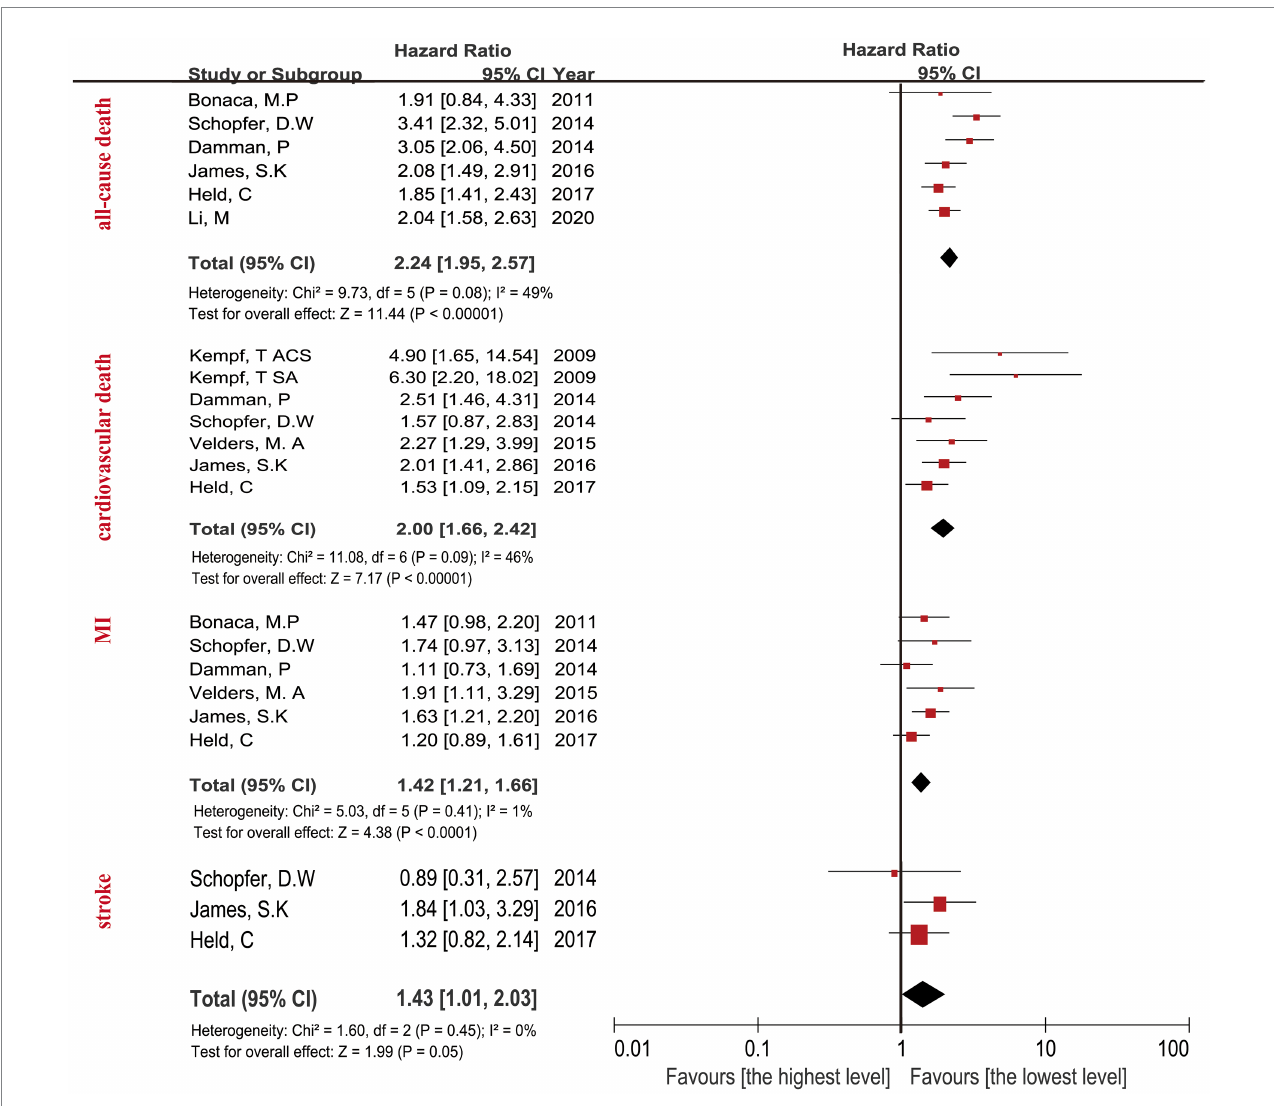
FIGURE 3 Forest plot showing the HR and 95% CI of individual cardiovascular events for studies comparing the highest and lowest concentrations of GDF-15 after adjustment clinical characteristics and other